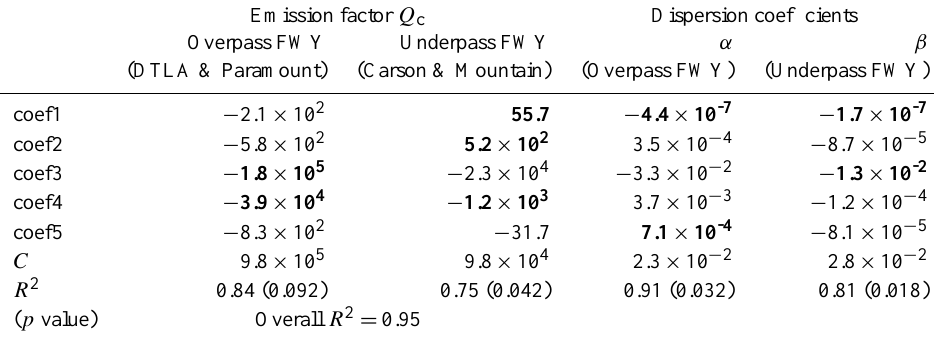
Table 3. Coefficients for α (for overpass freeways) and β (for underpass freeways) obtained from multivariate linear regression using Eq. (8). Bold fonts represent the dominant contributors in the